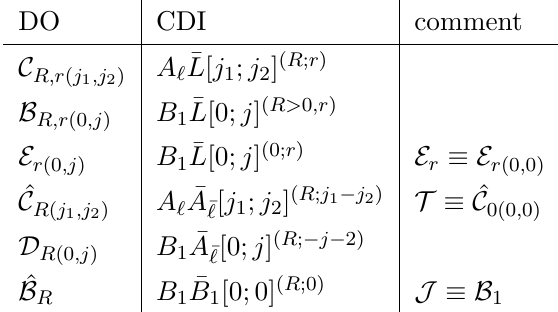
Table 2 . Short multiplets of 4d N = 2 SCFTs in Dolan-Osborn (DO) and Cordova-Dumitrescu- Intriligator (CDI)